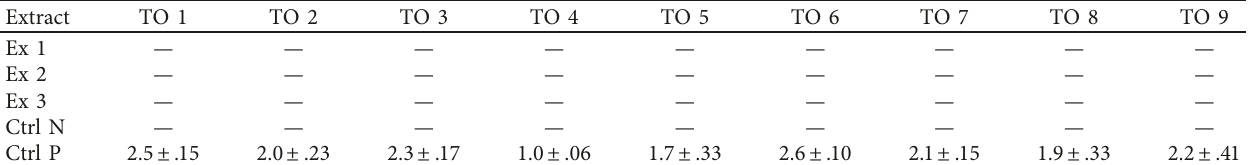
Table 5: Antimicrobial activity of fractions of leaves against test organisms.